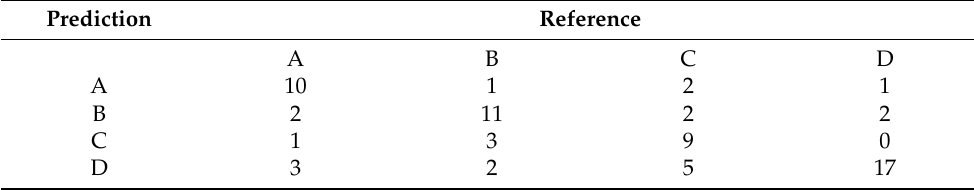
Table 3. Confusion matrix for LDA using all the wave numbers.